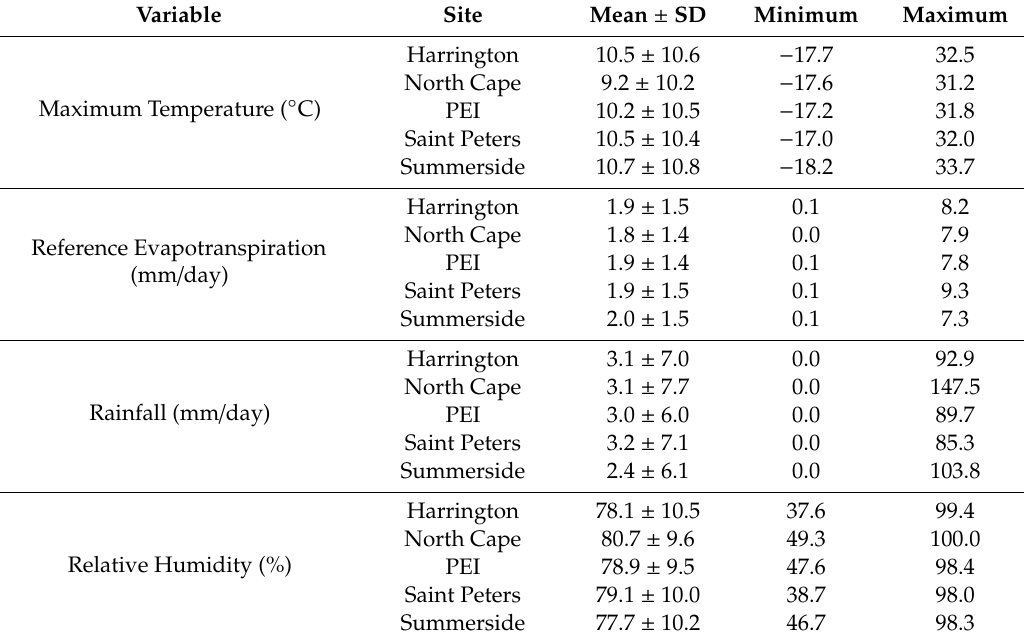
Table 3. Descriptive statistics of input and output variables for year 2011 to